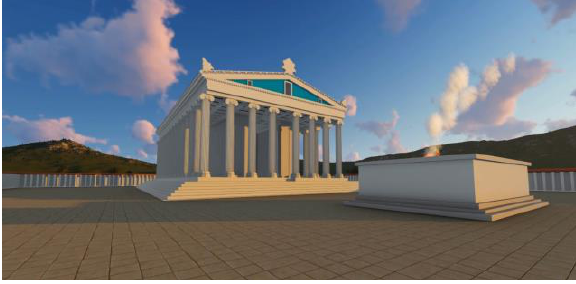
Figure 11. Reconstruction of the Temple of Artemis at Sardis